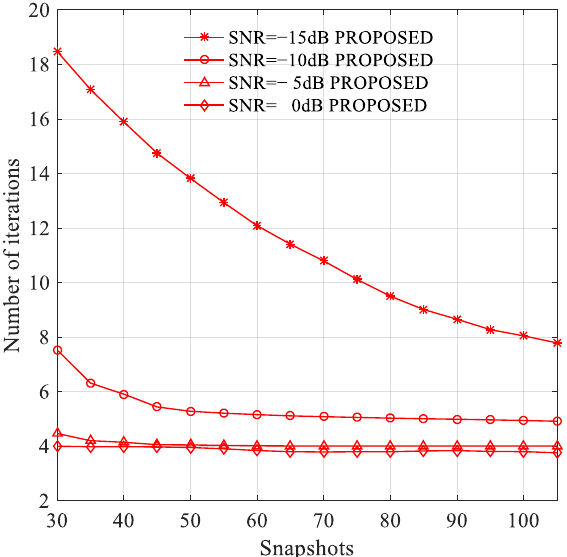
Figure 4. The number of iterations versus the number of snapshots.